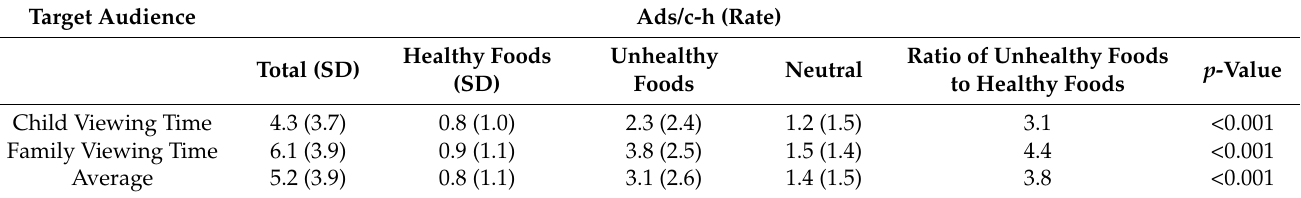
Table 1. Rates of advertising (ads) during child and family viewing